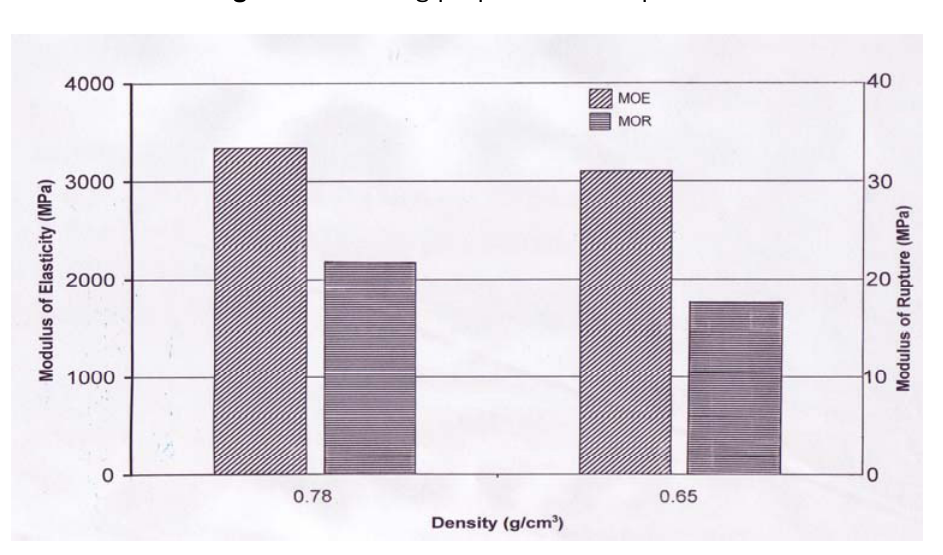
Figure 3. Bending properties of the